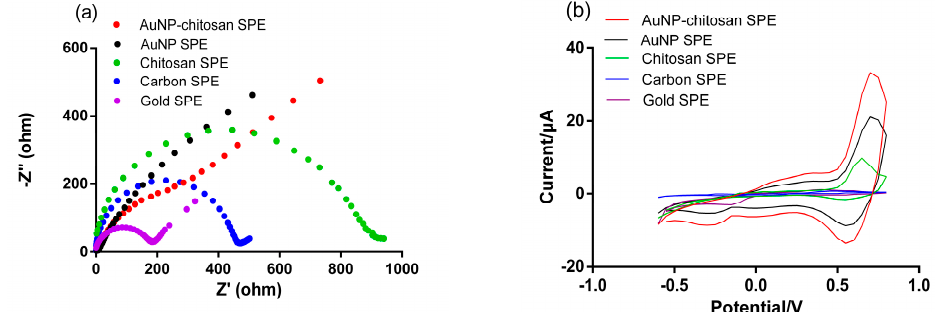
Figure 4. ( a ) Nyquist diagrams and ( b ) CV responses of a bare carbon SPE sensor, a bare gold SPE sensor, a biopolymer modified carbon SPE sensor, and an AuNP-biopolymer nanocomposite SPE sensor.